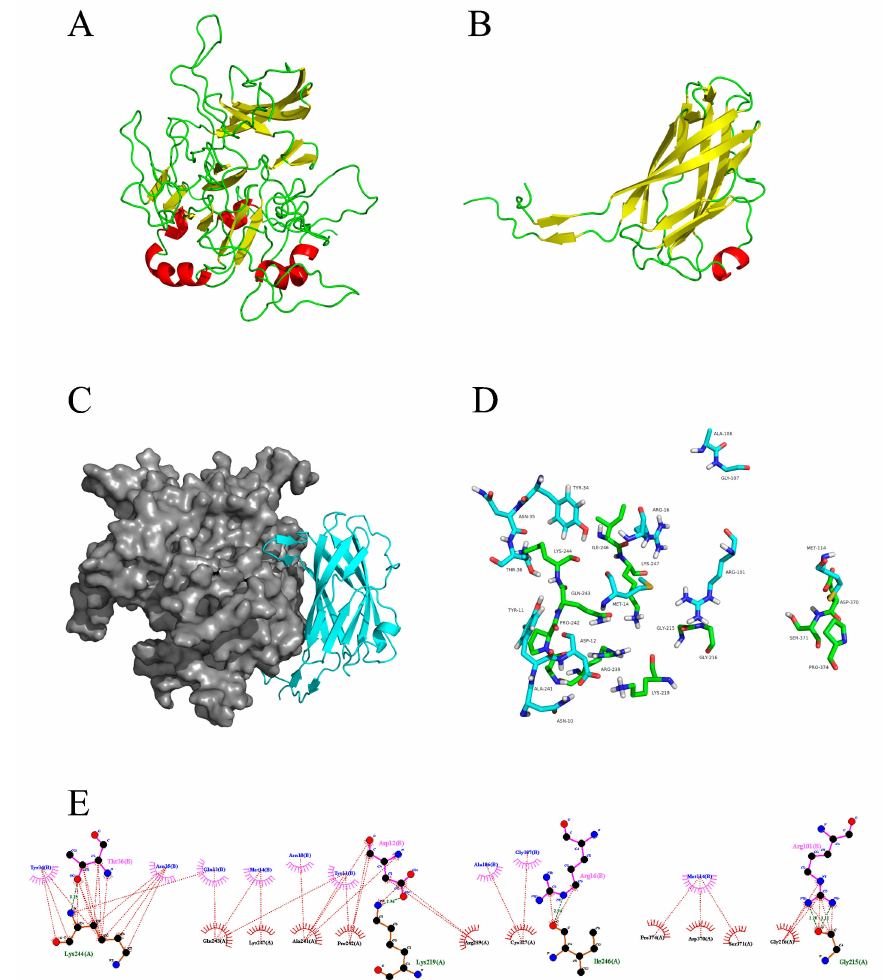
Figure 4. Protein interaction complexes of MjPellino with VP26 of WSSV. Three-dimensional models of ( A ) MjPellino and ( B ) VP26 of WSSV. ( C ) The three-dimensional models and interaction of MjPellino and VP26 were analyzed using Modeler 9.20 and ZDOCK. The interface residues of the MjPellino and VP26 proteins are shown as gray and blue spheres, respectively. ( D ) Action pattern diagram of MjPellino (green) and VP26 (blue). ( E ) Map of specific interaction sites and forces. Fourteen residues of MjPellino (GLY215, GLY216, LYS219, ARG239, ALA241, PRO242, GLN243, LYS244, ILE246, LYS247, CYS327, ASP370, SER371, and PRO374) and 12 residues of VP26 (ASN10, TYR11, ASP12, GLN13, MET14, ARG16, TYR34, ASN35, THR36, ARG101, ALA106, and